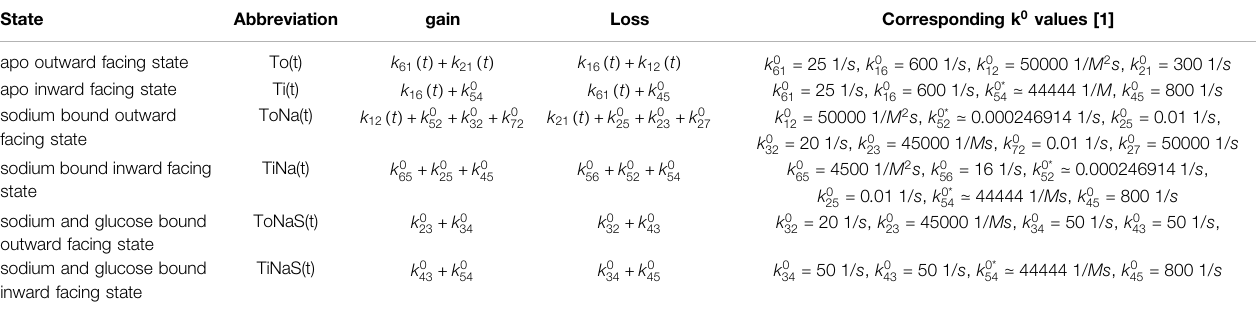
TABLE 3 | The six different states after Figure 8 and corresponding shortcuts used in the code implementation are listed in the fi rst two columns. The overall rate gain and loss is always contributed to the corresponding state in the row. The right column refers to the initial rates given at t (cid:2) 0 after Table S3 in Adelman et al. (2016). The remaining rates k 0* 54 and k 0* 52 were estimated according to Kirchhoff ’ s mesh rule by multiplying all rates along the states To — ToNa — ToNaS — TiNaS — TiNa — Ti — To and subtracting them from theotherdirectionbysetting thedifference tozero.For k 0* 52 themeshToNa — ToNaS — TiNaS — TiNa — ToNa wasused forevaluation.Values aregiven for 22 °